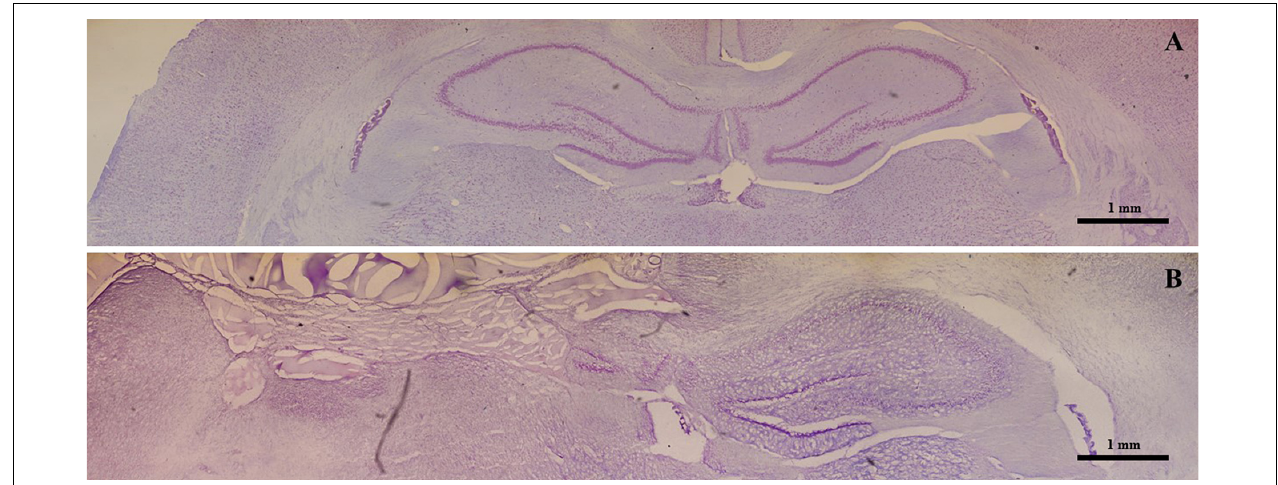
FIGURE 1 | Effective experimental unilateral removal of rat hippocampus. Photo-reconstruction of a Wistar rat brain stained with 0.1% thionin. (A) Coronal section obtained from a control animal presenting with the right and left intact hippocampus. (B) A section obtained from an animal submitted to a left hippocampectomy. Note the absence of the left